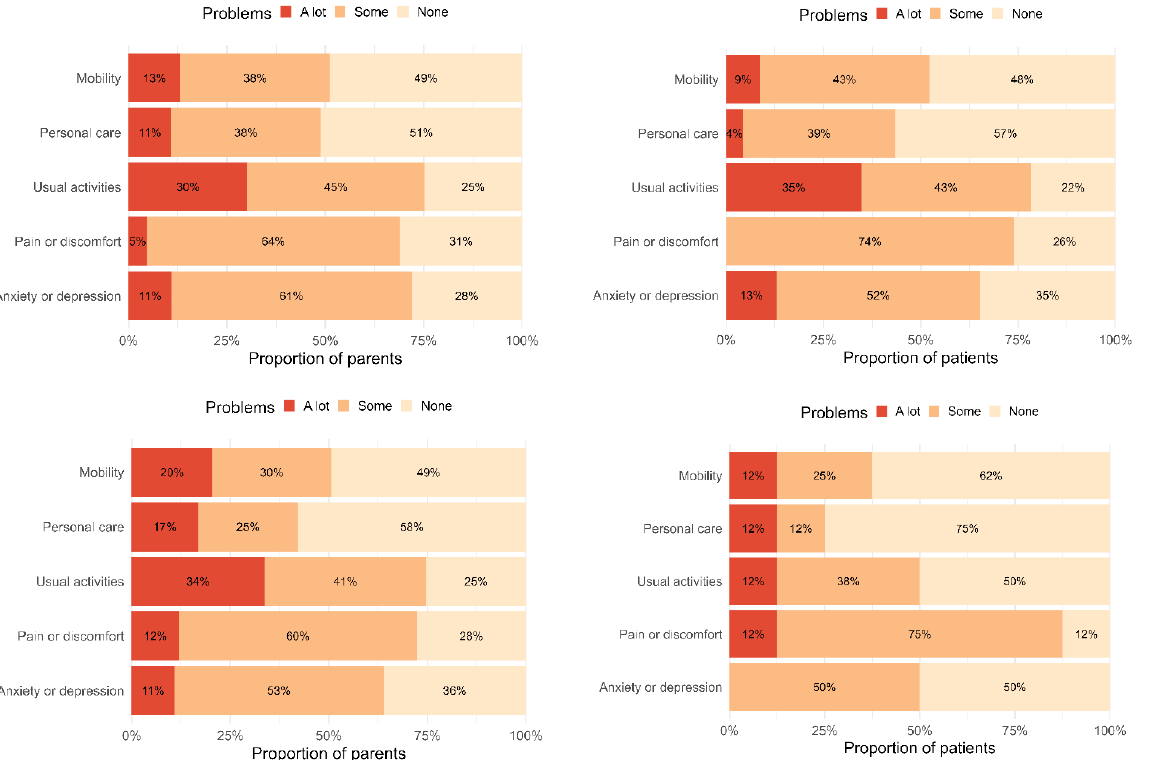
Figure 3. Patient self-report and parent-proxy QoL on EQ-VAS at T0 and T1.